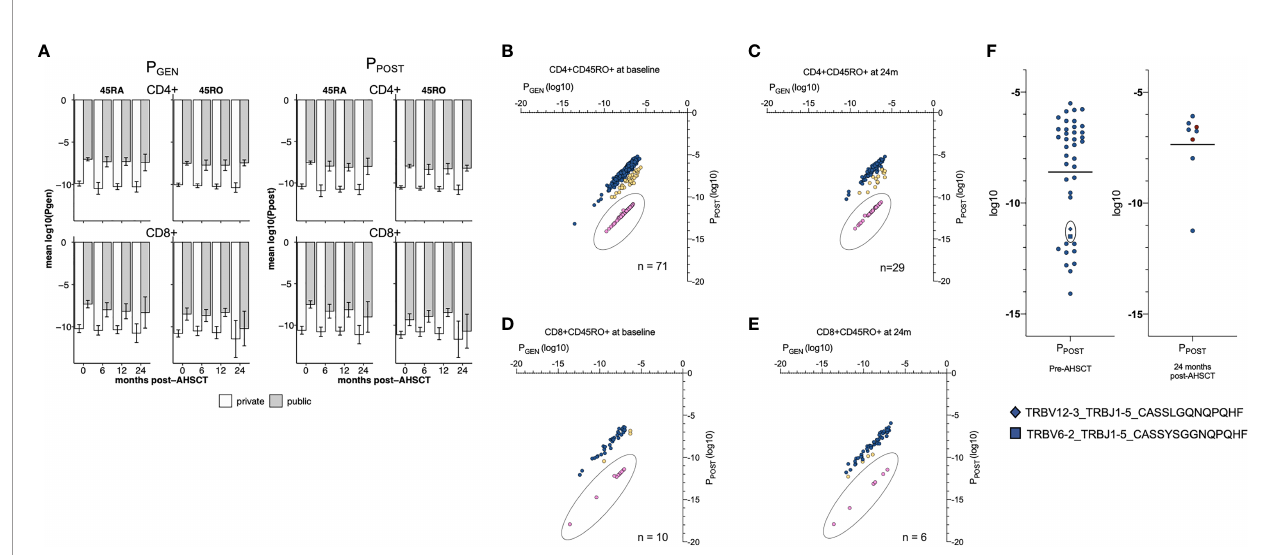
FIGURE 4 | Probability values T cell pro fi les. (A) The average P GEN (left panel) and P POST (right panel) of public and private clonotypes. Y-axis is mean log10. For CD4+ and CD8+ naïve and memory populations. CD4+ (left hand side) and CD8+ (right hand side) CD45RA+ (top half) and CD45RO+ (bottom half) lymphocyte pools are depicted. Within each lymphocyte pool, the mean P GEN and P POST (bar and single standard deviation, error bar) are depicted for public (grey) and private (white) clonotypes. At all timepoints the mean P GEN and P POST values are greater in the public clonotypes than private clonotypes, and signi fi cantly different in all lymphocyte subsets at all timepoints (p = <0.01) excluding the CD8+ memory pool at 24 months (p = 0.062). P GEN and P POST values of CD4+CD45RO+ (B) and CD8+CD45RO+ (C) public clonotypes at baseline and 24 months post-AHSCT (D, E) . The P GEN : P POST ratio was calculated for each clone. The P GEN : P POST ratio ranged from 1:1.38 to 1:7.4x10 -7 . Clones were then binned; 1:1.38 – 0.1 (blue, not rare), 1:0.1 – 1 x 10 -4 (yellow, intermediate) and 1:<1x10 -4 (pink, rare to survive thymic negative selection). Clones with a P GEN : P POST ratio 1: <1x10 -4 (pink) were considered a population of interest for possible self-reactive T cells. All public clones with a P GEN : P POST ratio 1: <1x10 -4 had a P POST value of <-10log10. (F) P POST values of public CD4+CD45RO+ clones in HLA DRB1*15:01 positive individuals pre- and 24 months post AHSCT. Within the 24-month plot, clones that were detected in the public repertoire at baseline have been depicted in dark red, n = 2. Two clones with a low P POST value (square, diamond) and signi fi cant sequence homology - sharing the GXNQPQHF motif – identi fi ed pre-AHSCT were undetectable at any time point in any patient post-AHSCT and were also detected in NTZ02. Error bars (black) depict the mean. Using a Mann-Whitney unpaired non-parametric t-test there was no signi fi cant change between mean probability values pre- to